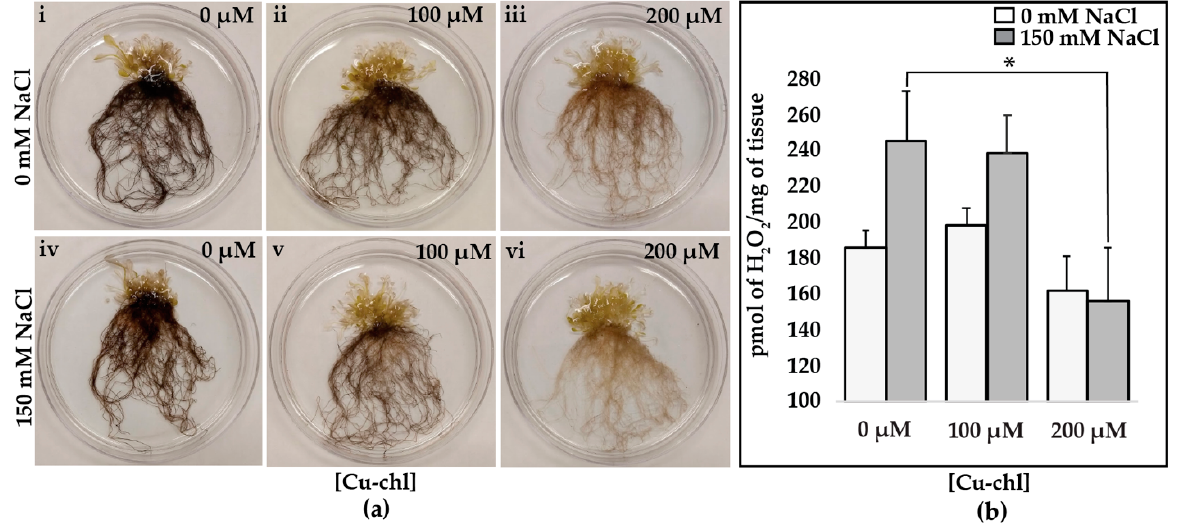
Figure 1. Copper chlorophyllin, Cu-chl, induced changes in cellular H 2 O 2 accumulation under salt stress. Seedlings were grown in four biological replicates for each treatment under the same growth conditions. Finally, two of them were used for diaminobenzidine (DAB) assay and the other two for the Amplex ® Red assay, and the whole experiment was repeated twice: ( a ) DAB staining of A. thaliana seedlings in the absence (i–iii) of salt and after 3 h salt treatment (iv–vi). Note the lighter DAB staining in seedlings treated with 200 µM Cu-chl. ( b ) Quantification of H 2 O 2 by Amplex ® Red assay. Mean ± SE was calculated from two biological and three technical replicates for each treatment. Asterisk indicates significant difference ( p = 0.05) according to two-sample t-test.